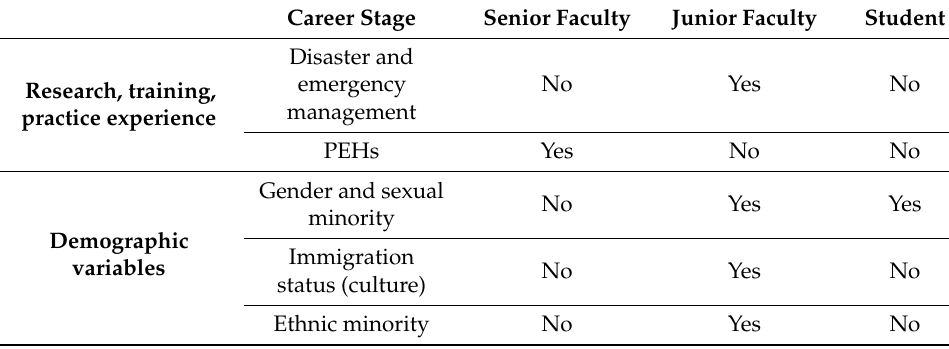
Table 1. Team’s academic and demographic